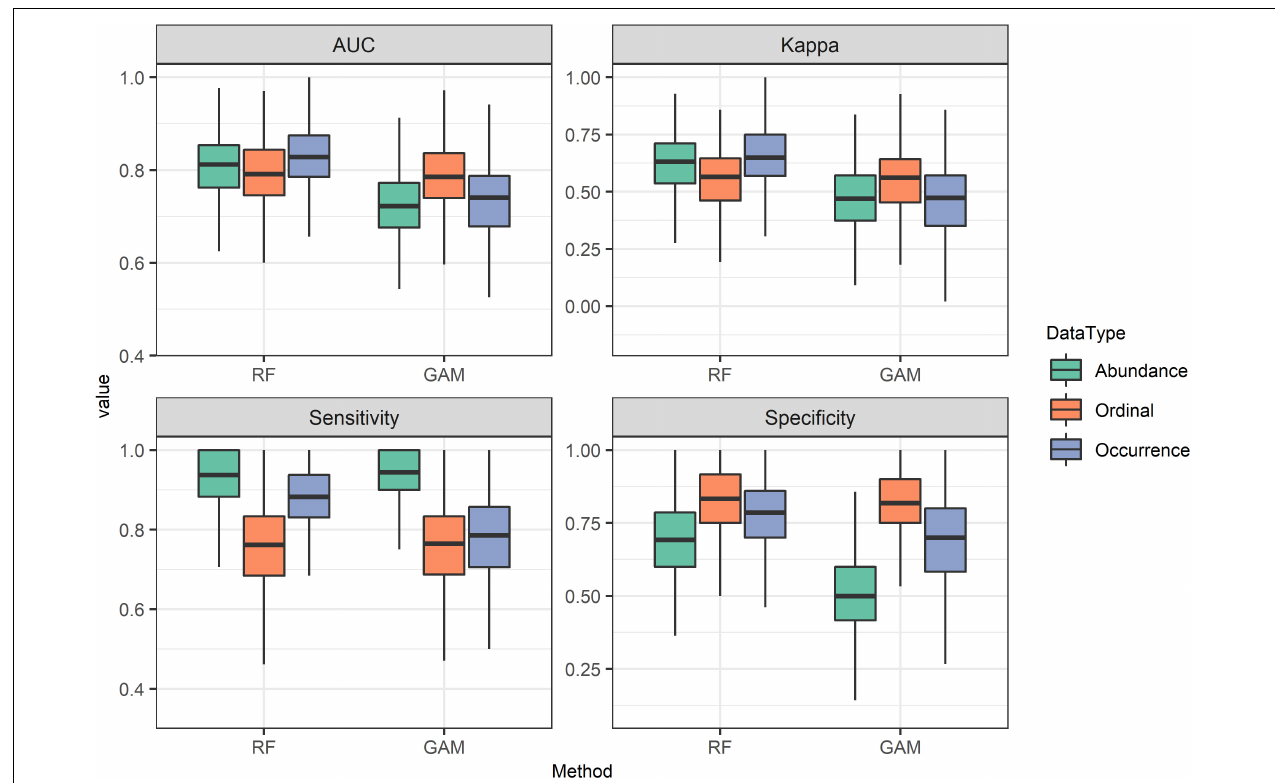
FIGURE 2 | The accuracy metrics for predicting occurrence of O. oratoria between the models based on three data types in two modeling algorithms.